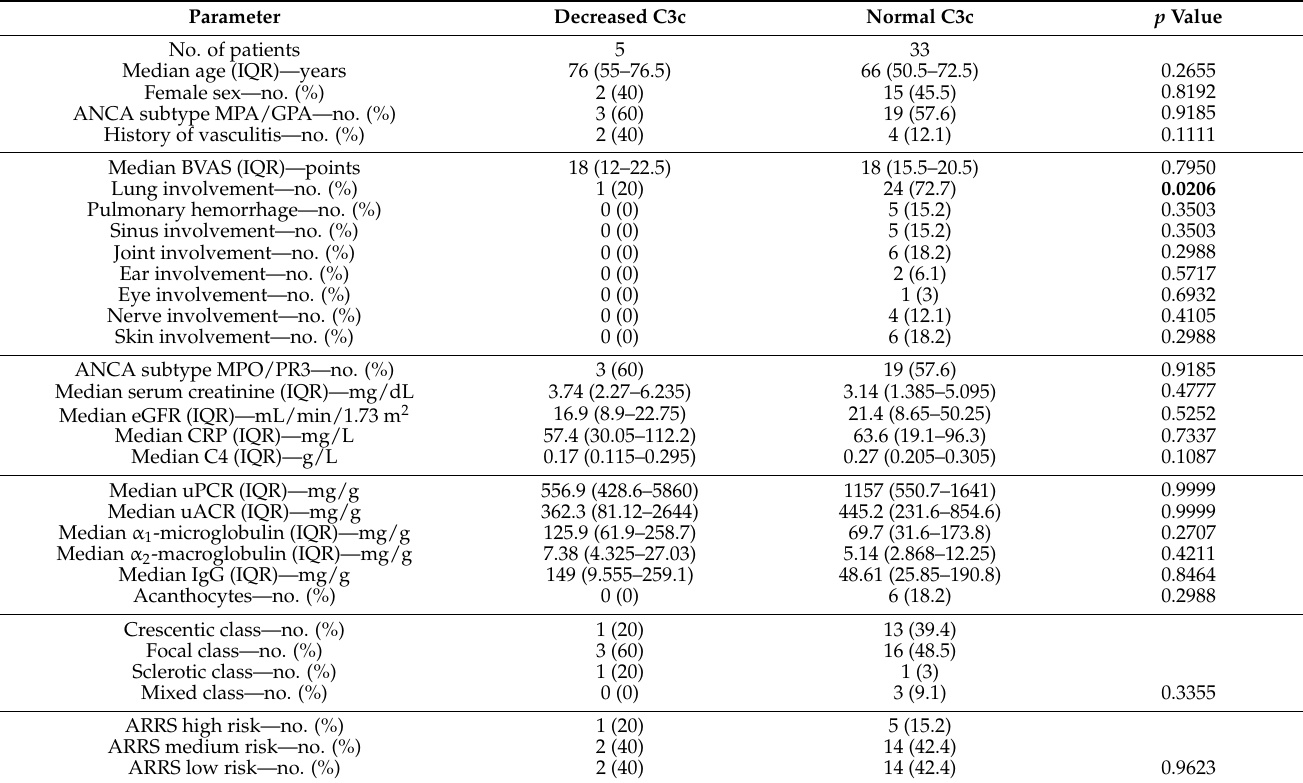
Table 2. Baseline patient characteristics according to circulating C3c levels (normal range: 0.82–1.93